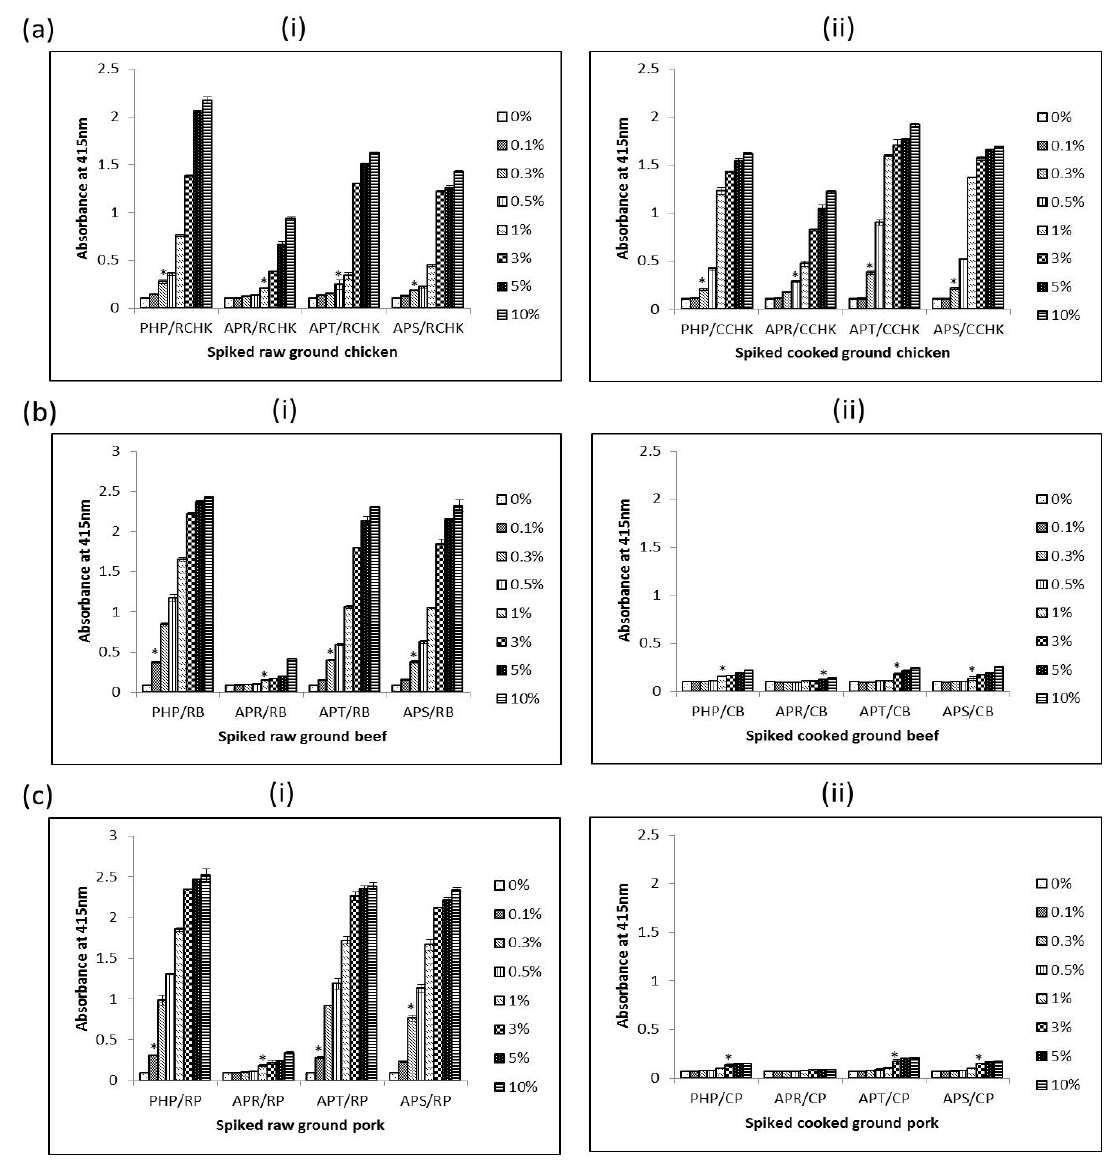
Figure 6. Detection limit of PHP, APR, APT, and APS in raw ( i ) and cooked ( ii ) ground chicken ( a ), ground beef ( b ) and ground pork ( c ) using 24C12-E7 based iELISA. Results are expressed as A 415 ± SD, n = 3. An asterisk (*) indicates a significant difference ( p < 0.05) from background (0%). RCHK: raw ground chicken; CCHK: cooked ground chicken; RB: raw beef; CB: cooked beef; RP: raw pork; and CP: cooked